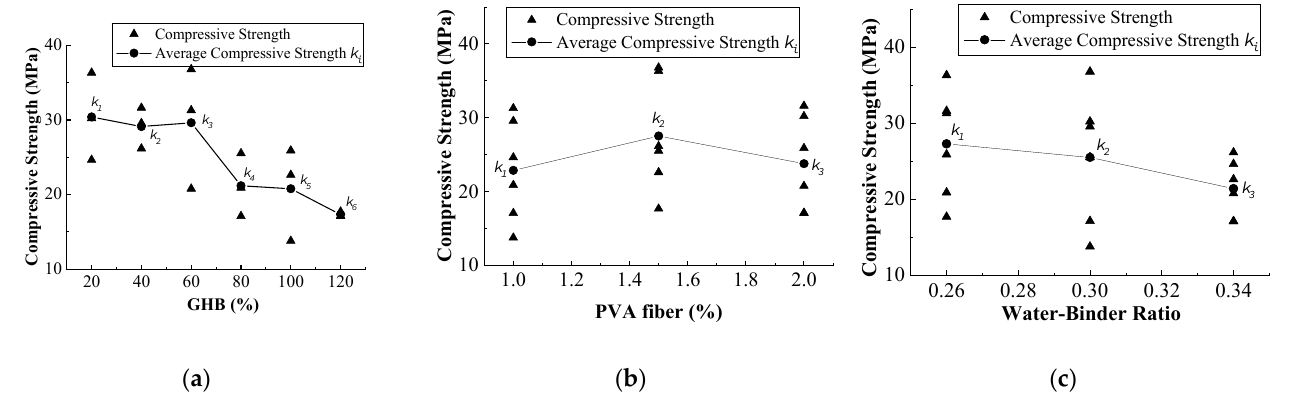
Figure 4. Relationship of GPCC compressive strength with each factor: ( a ) GHB content; ( b ) PVA fiber content; ( c ) water-binder ratio.